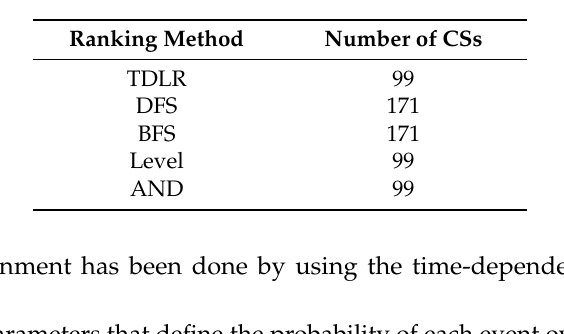
Table 3. Ranking methods and CSs.